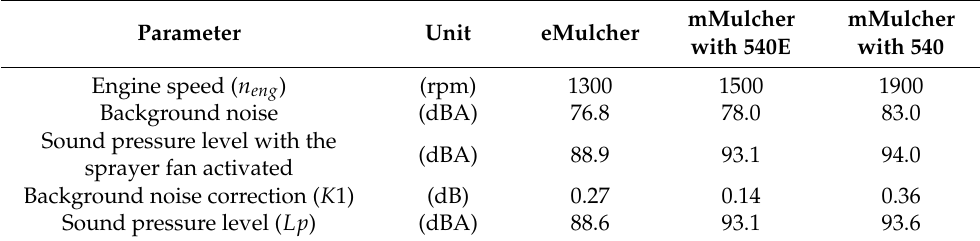
Table 9. Noise tests results with the